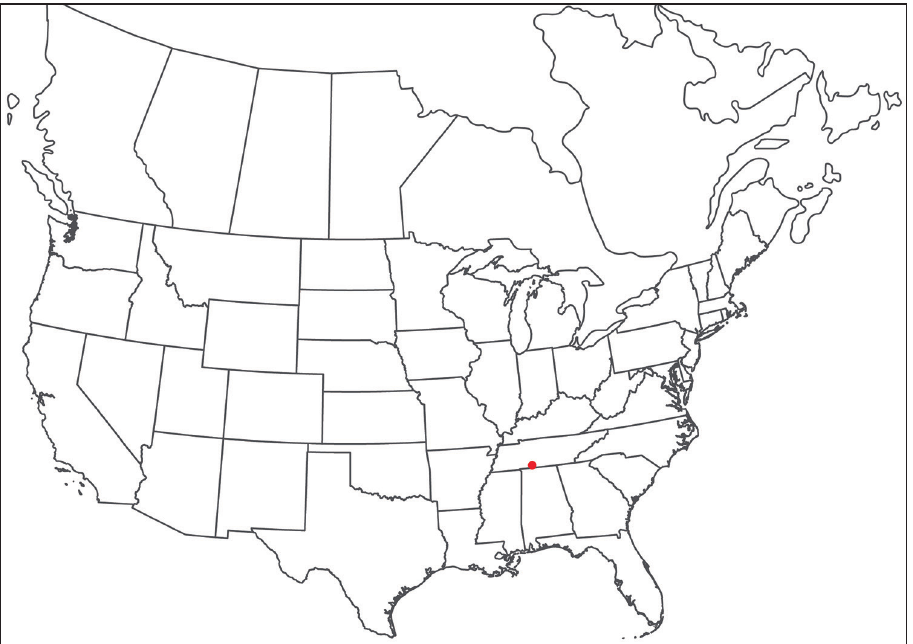
Figure 35. Torrenticola caerulea sp. n.